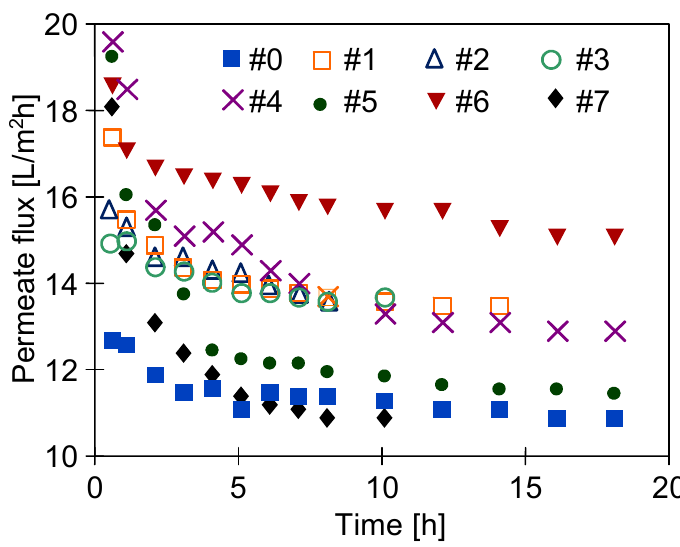
Figure 12. Changes in permeate flux during water desalination by the MD process performed after 4 years of membrane storage.